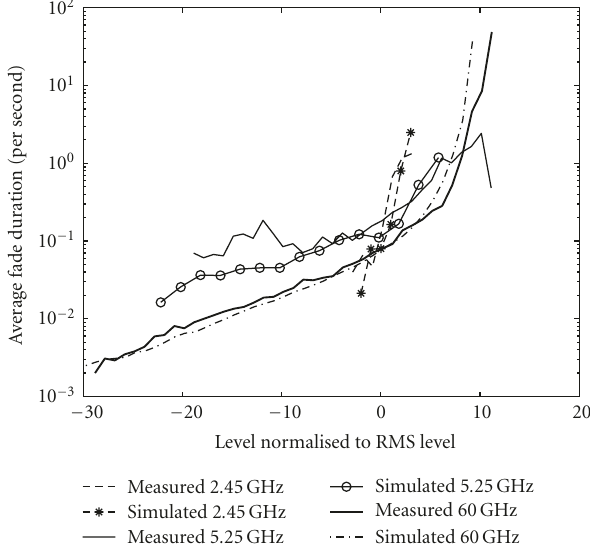
Figure 16: ACFs of measured (dry leaved deciduous trees (Site 1)) and simulated (using the new model) signals at 2.45, 5.25, and 60GHz during high ( w m = 5m/s) wind speed conditions. All simulation parameters are given in Table 3.